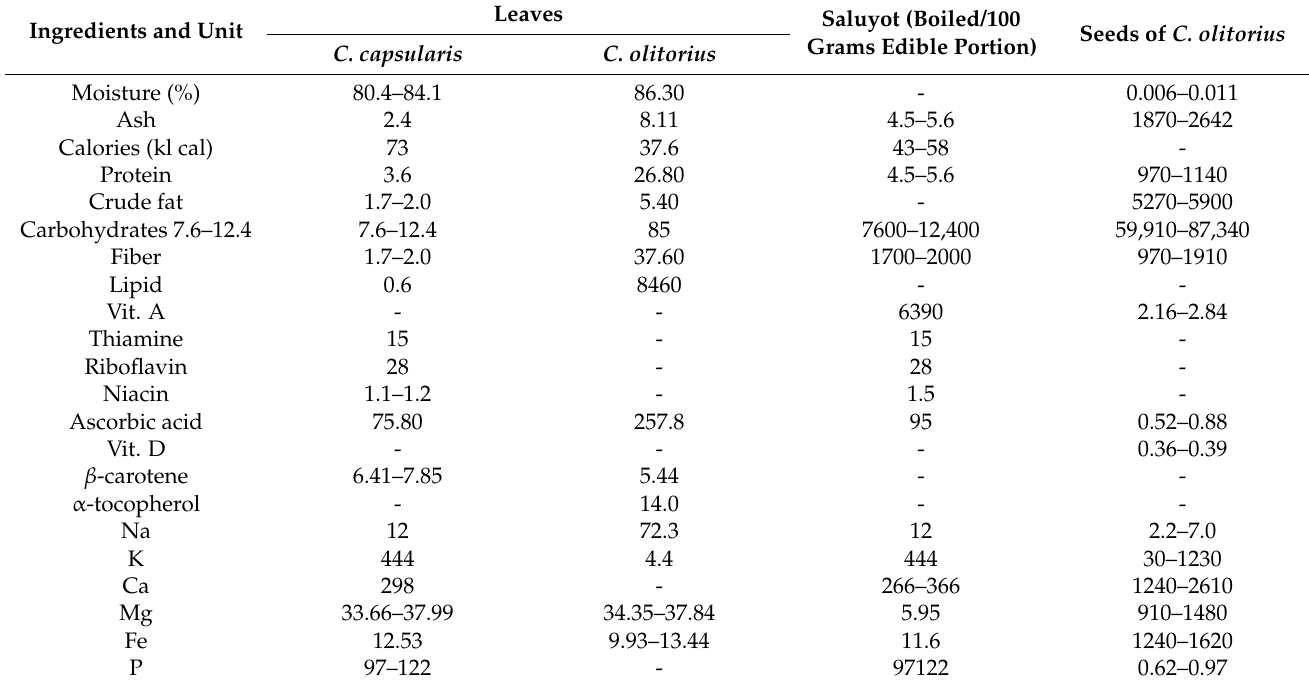
Table 2. Nutritional comparison of C. capsularis and C. olitorius mg per 100 g